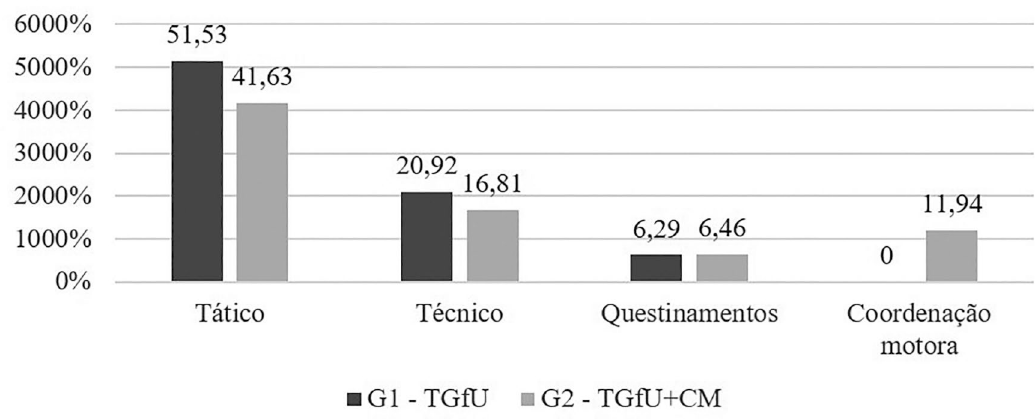
Figure 1 - Pedagogical characteristics of the TGfU model applied in this study for both groups, according to the stimulated capacities. TGfU: Teaching Games for Understanding; MC: motor